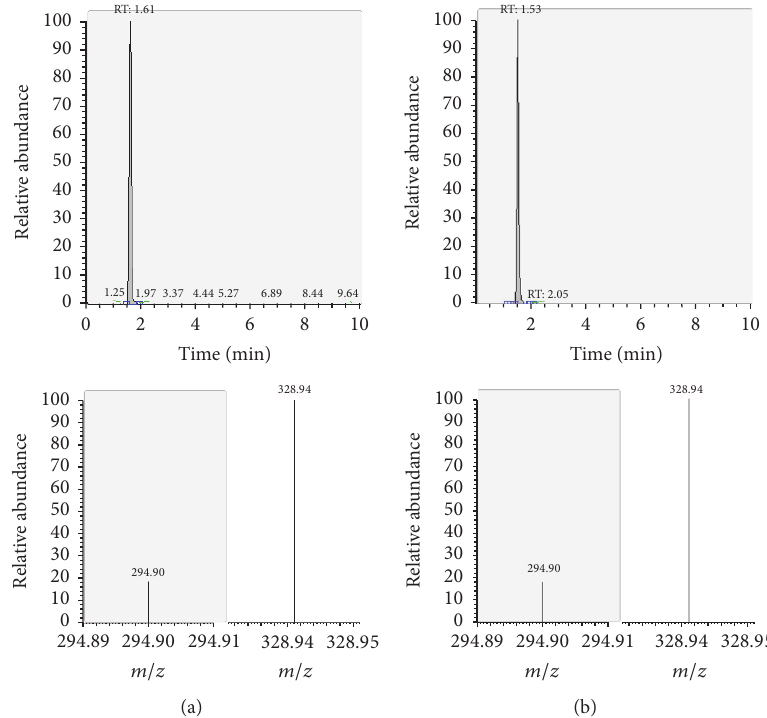
Figure3:LC-MS/MSchromatogramsofPDLandSRMtransitionsandrelativeabundances.(a)Standardina100 𝜇 gL −1 solution.(b)Standard in the spiked sample at 100 mgkg −1